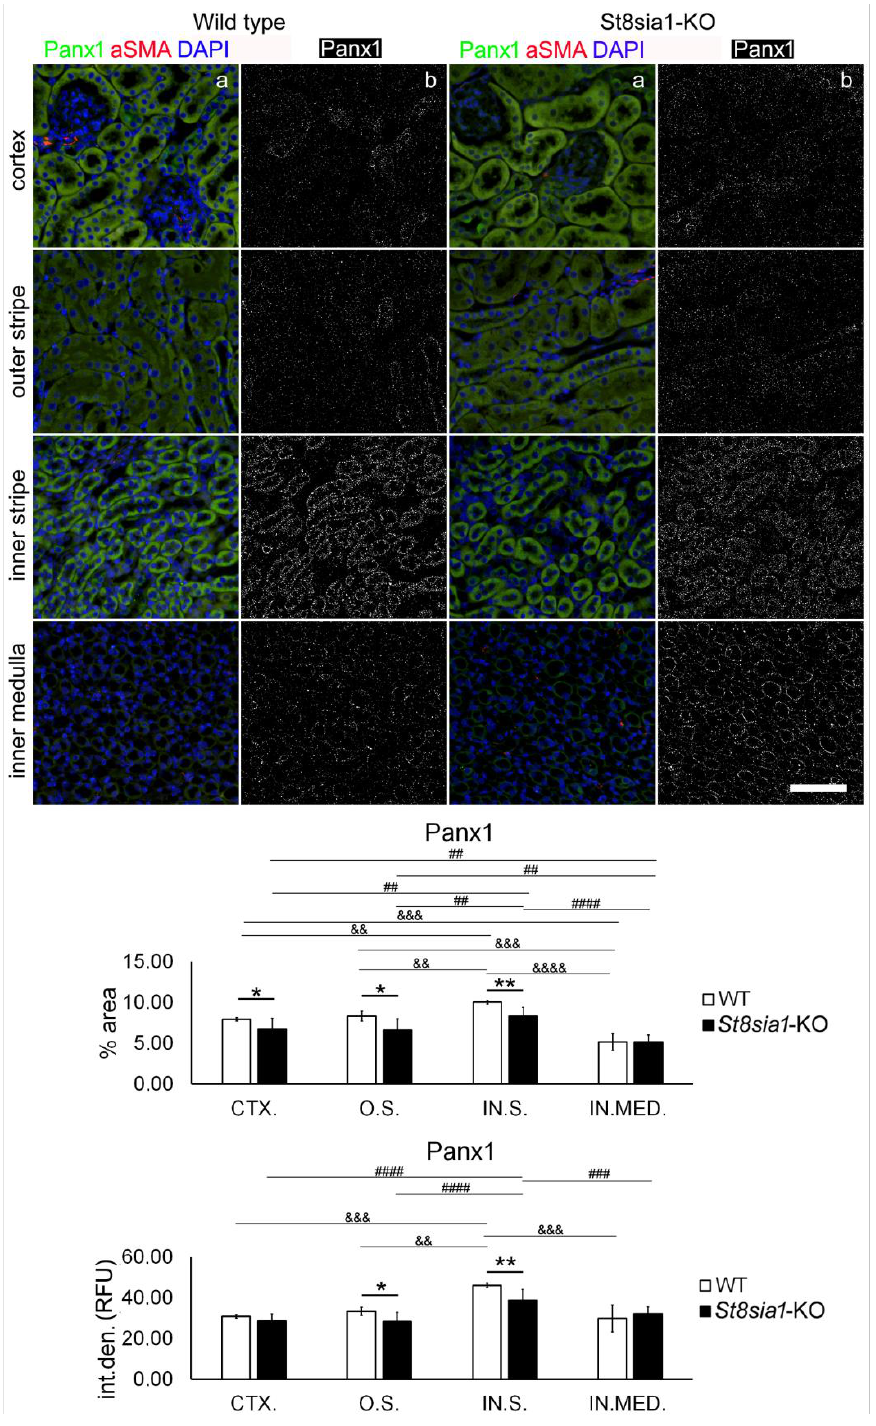
Figure 8. Expression of pannexin 1 in different renal parts of the wild type and St8sia1 -KO mice. WT—wild-type mice; St8sia1 -KO— St8sia1 knockout mice; CTX.—Cortex; O.S.—outer stripe of outer medulla; IN.S.—inner stripe of outer medulla; IN.MED.—inner medulla; % area—percentage of the section area occupied by Panx1 immunofluorescence; int.den. (RFU)—integrated density (relative fluorescence units). Column a—representative photomicrographs of the indicated kidney sections stained with Panx1 (green) and alpha-smooth actin (red) antibodies; nuclei are stained in blue. Column b—(same section as a) processed and thresholded photomicrographs prepared for analysis (inverted black for white on thresholded green image). Statistically significant difference between WT and St8sia1 -KO: * p < 0.05; ** p < 0.01; (t-test for unequal variances). Comparison between different kidney areas in the same group of mice WT: && p < 0.01, &&& p < 0.001, &&&& p < 0.0001; or